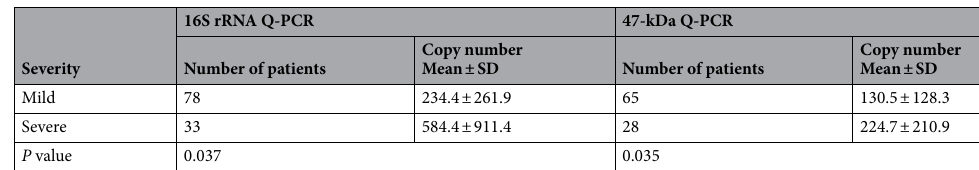
Table 2. Mean copy number detected using 16S rRNA Q-PCR and 47-kDa Q-PCR according to the severity grade divided into 2 levels. ‘Number of Patients’ indicates the number of positive patients detected by each PCR method for patients without prior antibiotics treatment. SD standard deviation.